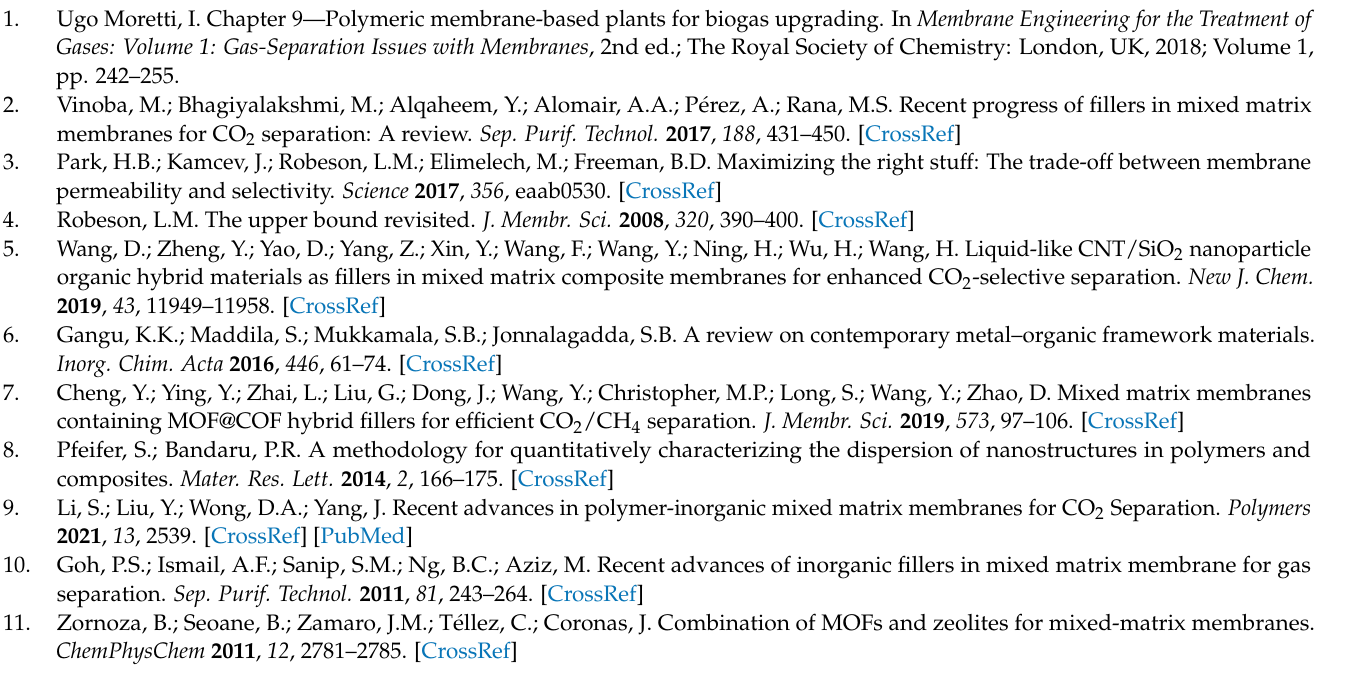
maximum height of the synthesized membranes determined by the 3D optical non-contact profiler. Table S2: Langmuir sorption isotherm fitting parameters for CO 2 sorption in the CTA- CeO2@GO membrane